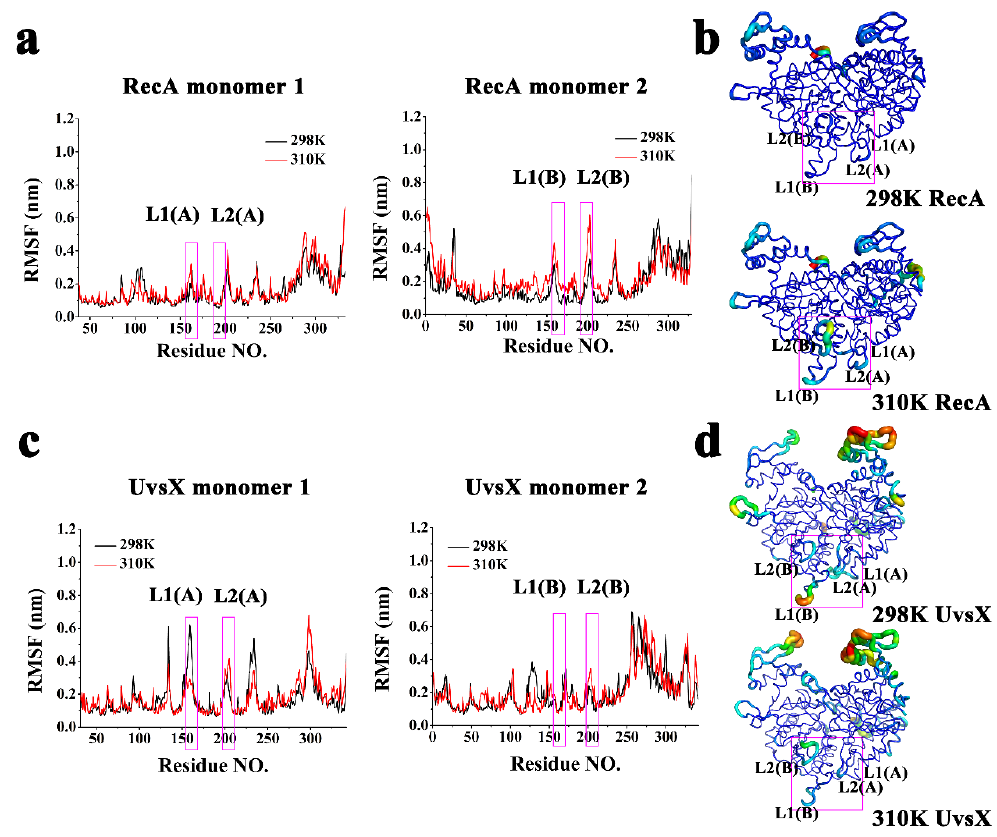
Figure 2. ( a ) RMSF curves of RecA monomers; ( b ) Visualizations of the backbone flexibility of RecA; ( c ) RMSF curves of UvsX monomers; ( d ) Visualizations of the backbone flexibility of UvsX. (The DNA binding domains were framed with pink